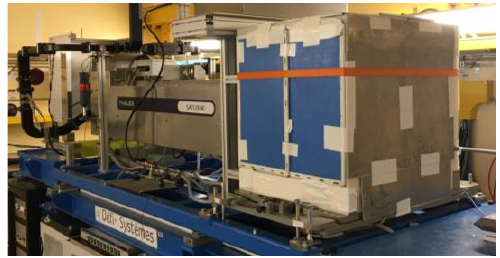
Fig. 1. SATURNE LINAC with its neutron shielding housed in the CINPHONIE casemate.